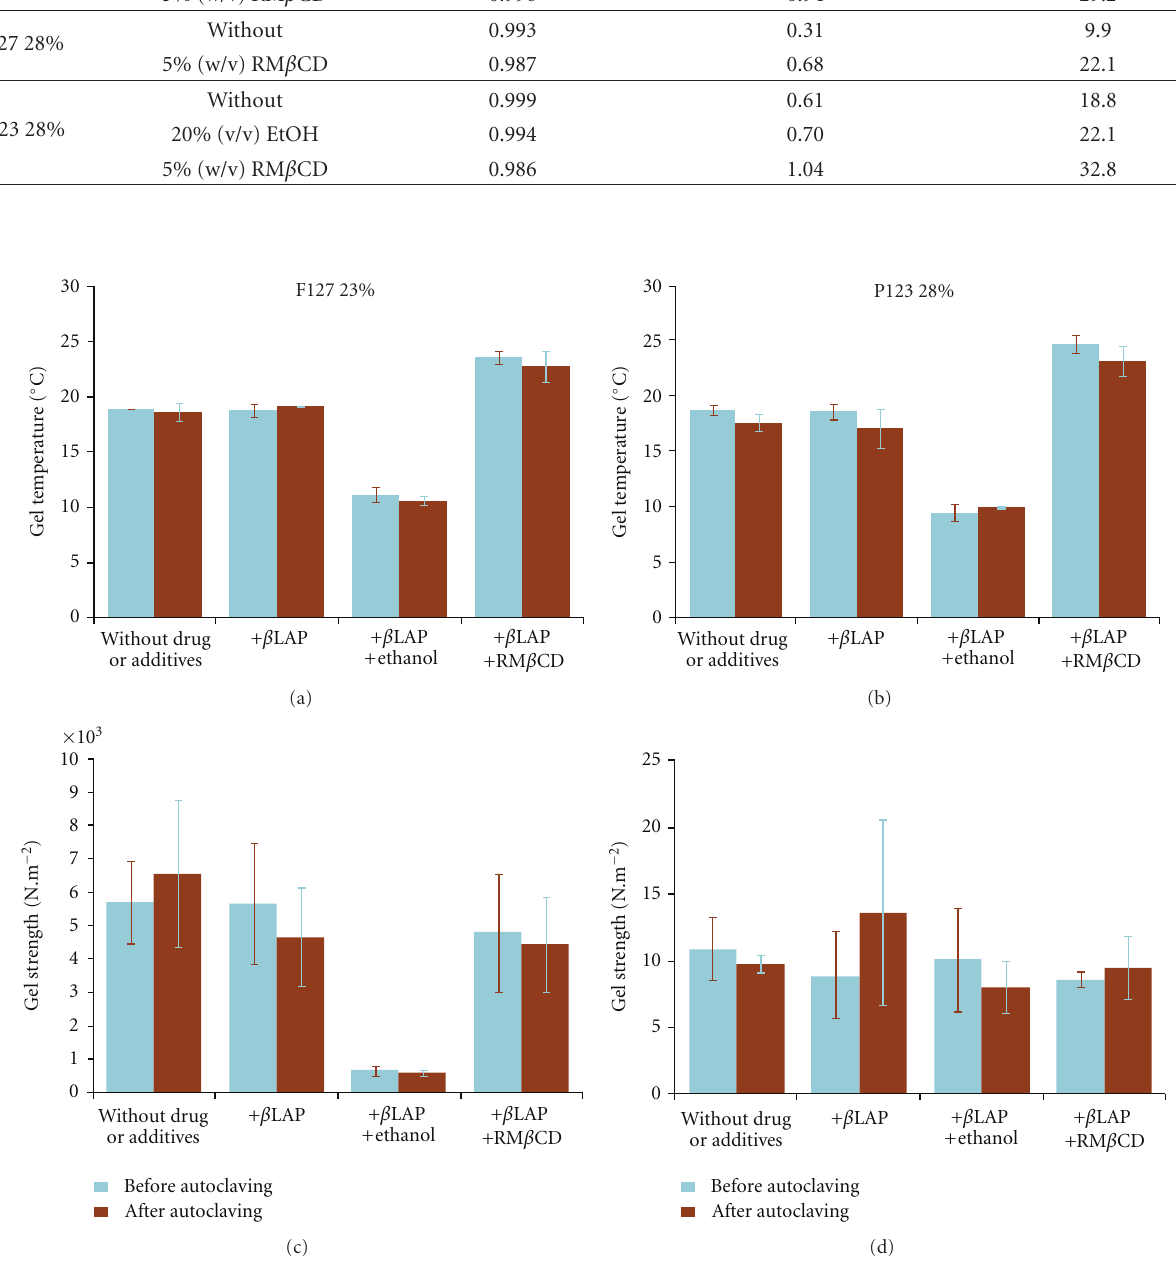
Figure 3: Gel temperature and gel strength at 37 ◦ C of Pluronic systems before and after